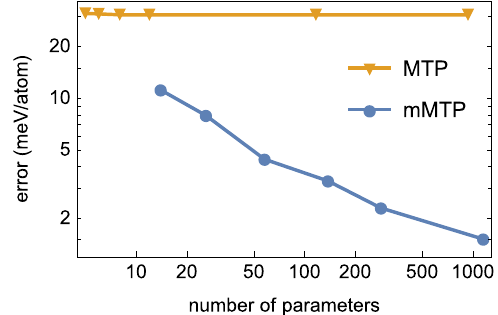
Fig. 1 Convergence of the magnetic potential, mMTP, with respect to DFT energies and lack of convergence for the non- magnetic MTP. The graph indicates that most variation of the energy on the training set is in the magnetic degrees of freedom that can be captured only by the magnetic